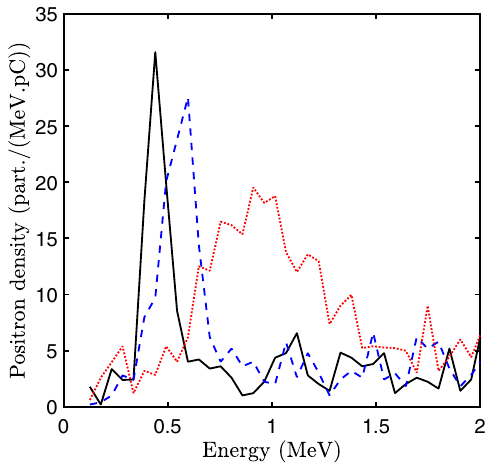
FIG. 12. Example of energy selection after the dogleg. All distributions correspond to a 4.9 mm wide position selection centered on ∼ 72 . 0 mm (black solid line), ∼ 55 . 9 mm (blue dashed line), ∼ 34 . 6 mm (red dotted line) from the main